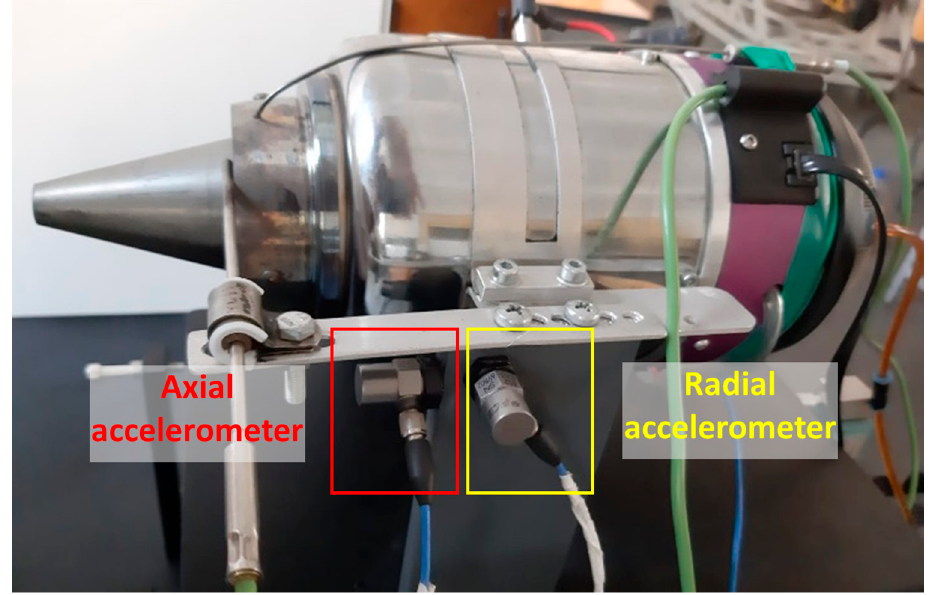
Figure 5. Test bench instrumentation and accelerometers location.